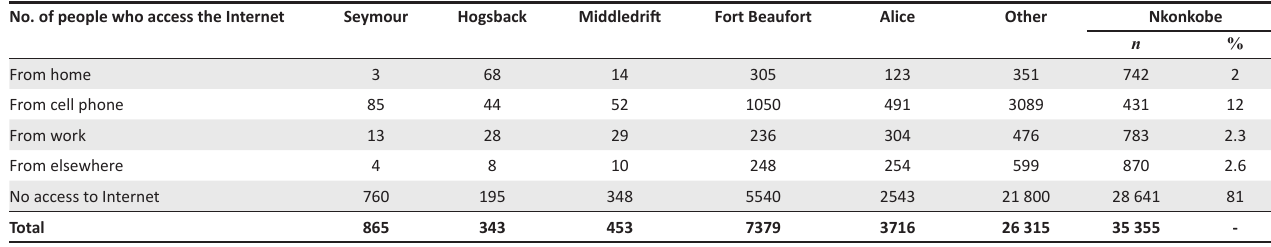
TABLE 1: Access to the Internet in Nkonkobe (Census 2011). No. of people who access the